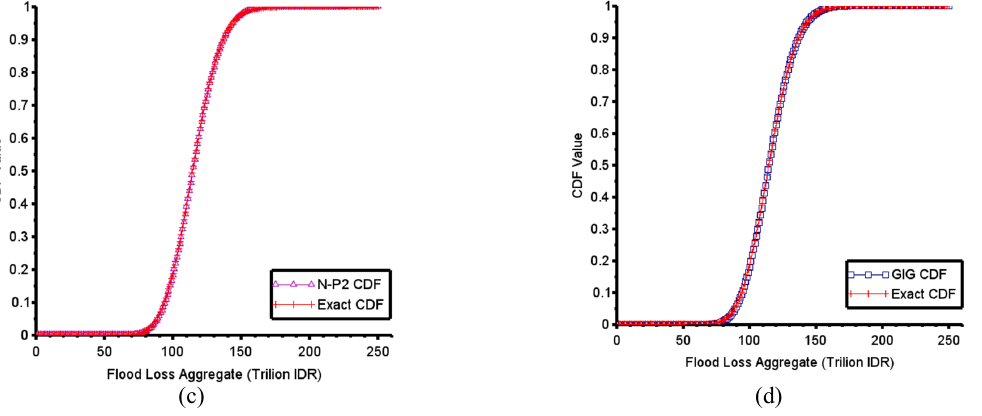
Fig. 2 . Visualisation of Approximation Method for Normal (a) , Gamma (b) , N-P2 (c) , and Gamma Inverse Gaussian (d) Distributions with Exact Distribution of Flood Loss Aggregate